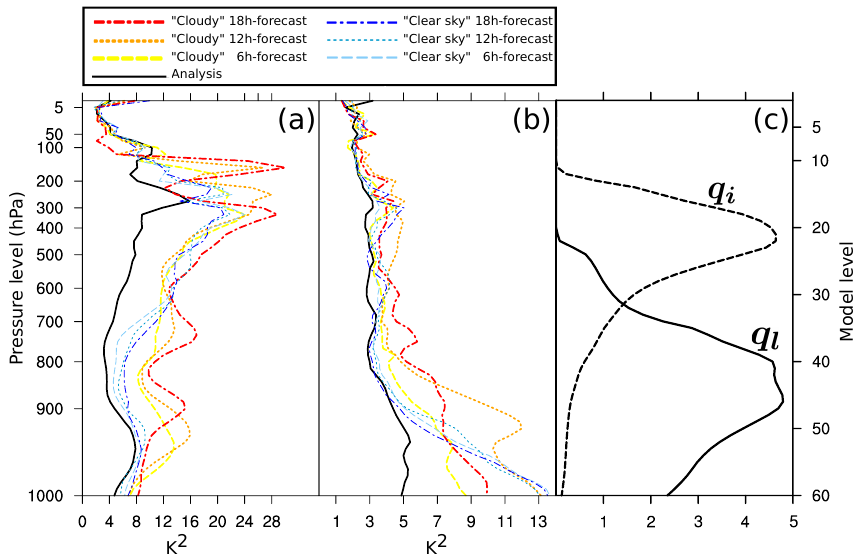
Figure 6. Time evolution of the vertical profiles of K 2 for (a) q and (b) T computed for (thick and hot colours) cloudy and (thin and cold colours) clear-sky points (see text). (c) Vertical profiles of liquid cloud q l (solid line) and ice cloud q i (dashed line) contents (gkg − 1 ). The cloud contents are averaged over the domain and over times from 06:00 to 18:00UTC, every 6h. Initial cloud water profile is null because the hydrometeors are not cycled. Consequently the initial time profiles of K 2 are common for the two bins. Profiles have been computed from 00:00 to 18:00UTC, every 6h, using forecasts initialized with analysis states valid on 4 November 2011, 00:00UTC.